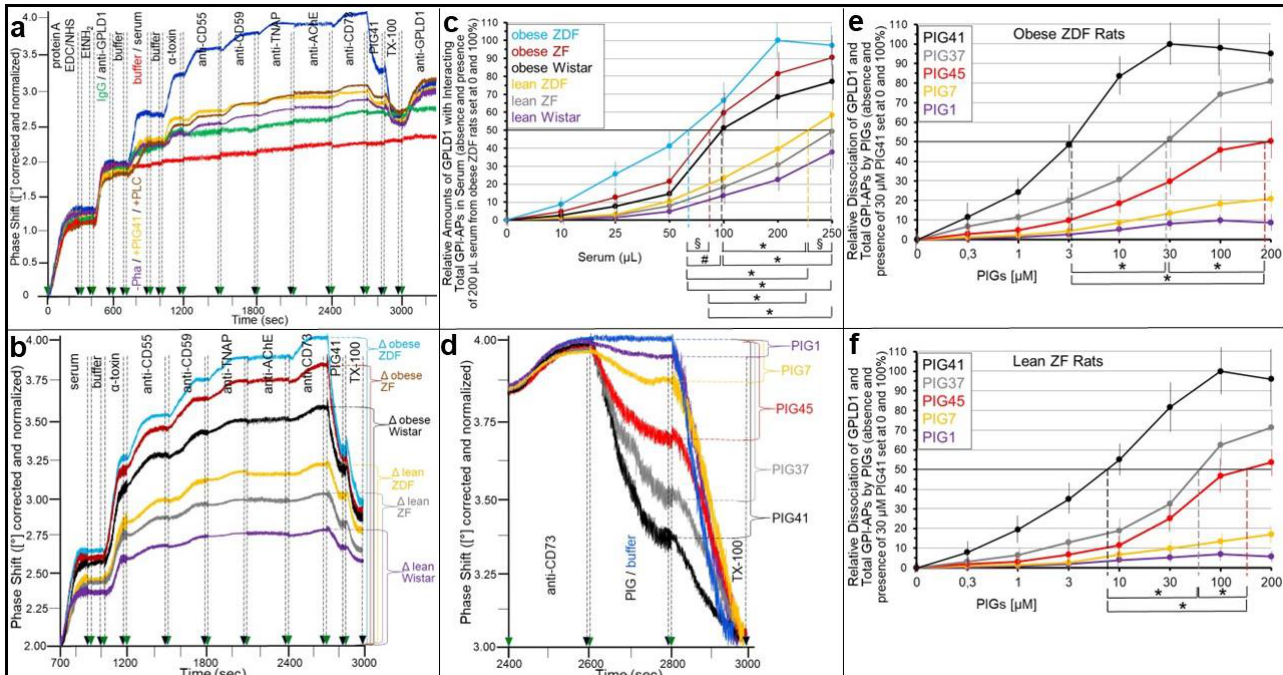
Figure 8. Binding to and displacement by PIGs from GPLD1 of full-length GPI-APs of serum from metabolically dysregulated rats. ( a ) After the covalent immobilization of protein A onto EDC/NHS- activated chips (0–300 s) and subsequent blockade of unreacted carboxyl groups by ethanolamine (EtNH 2 ) (300–400 s), monoclonal anti-GPLD1 antibody (blue, yellow, brown and turquoise curves) or IgG (green curve) was injected into the chip channels. Following the washing of the chips (600–700 s), serum (200 µ L, prepared from obese ZDF rats and then diluted 10-fold with PBS containing 2 mM Pha), which was pretreated with bacterial PI-PLC (0.2 mU/mL, brown curve) or remained untreated (blue, yellow, turquoise and green curves), or buffer (red curve) was injected (700–900 s) at a flow rate of 60 µ L/min in the absence (turquoise curve) or presence of 1 mM Pha (all other curves) or 30 µ M PIG41 (yellow curve). After washing of the channels with buffer (900–1000 s) at a flow rate of 200 µ L/min and then with α -toxin (30 µ g/mL, 1000–1200 s), anti-CD55 (1200–1500 s), CD59 (1500–1800 s), TNAP (1800–2100 s), AChE (2100–2400 s) and CD73 (2400–2700 s) antibodies (at the dilutions given in Supplementary Materials, Materials) were injected successively at a flow rate of 15 µ L/min. After the injection of 30 µ M PIG41 (2700–2850 s) together with 4 mM Ca 2+ and then 0.2% TX-100 (2850–3000 s) at a flow rate of 45 µ L/min, polyclonal anti-GPLD1 antibody was finally injected (3000–3300 s) at a flow rate of 15 µ L/min. The experiment was repeated two times (distinct chips) with similar results (representative shown). Phase shift is given upon correction for unspecific interaction of serum components (“mock” channel lacking protein A) and altered viscosity (vs. buffer) of the sample fluid and normalization for the varying efficiencies of distinct chips for capture of protein A. ( b ) The experiment was performed as described (see ( a ), blue curve; chips with immobilized anti-GPLD1, absence of PIG41) using untreated sera prepared from rats of different metabolic states and diluted with PBS containing 2 mM Pha) as indicated and repeated four to six times (distinct chips with four injections per incubation) with similar results (representative shown). The measured phase shift was corrected (see ( a )) and is only shown from the start of serum (700 s) to the end of TX-100 injection (3000 s). Phase shift increases induced by serum, α -toxin and antibodies (700–2700 s) are indicated for each type of serum (horizontal, hatched lines and brackets). ( c ) The experiment was repeated (see ( b )) three to five times (distinct chips with four to six injections per incubation) with increasing volumes (i.e., adjusting the flow rate from 15 to 75 µ L/min to cover 50–250 µ L and from 30 to 75 µ L/min to cover 10–25 µ L) of the untreated sera (diluted 1:10 and 1:100 with PBS containing 2 mM Pha, respectively) from rats of different metabolic states as indicated. The relative amounts of GPLD1 with interacting GPI-APs, as reflected in the sum of the serum-, α